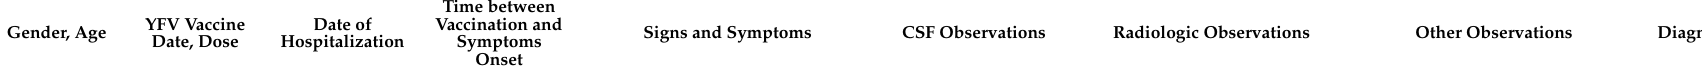
Table 1. Clinical data from the patients with yellow fever vaccine-related neurological disease detected in S ã o Jos é do Rio Preto, S ã o Paulo, Brazil in